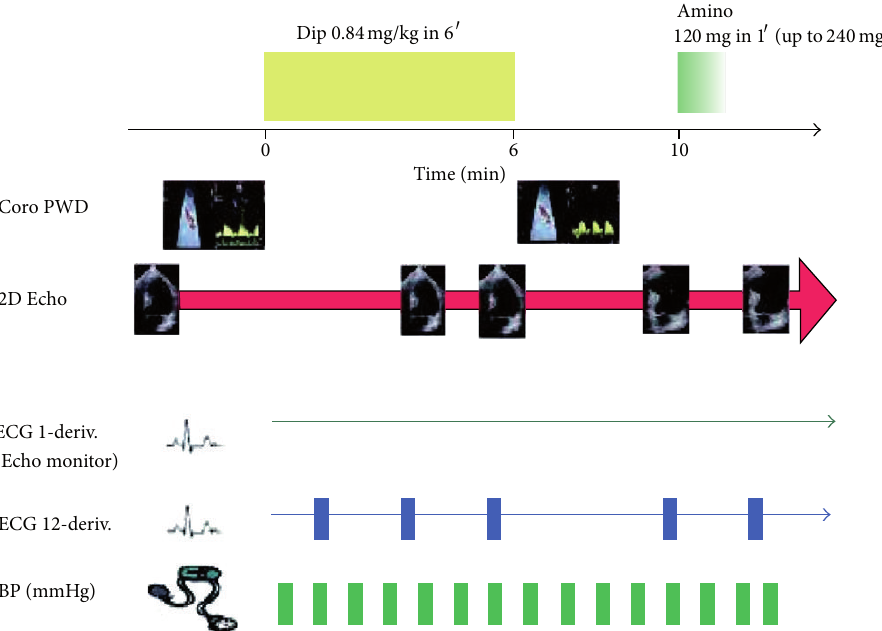
Figure 1: Scheme of “fast” protocol with dipyridamole for evaluating CFR and regional wall motion according to the recommendations of the European Association of Echocardiography [6].